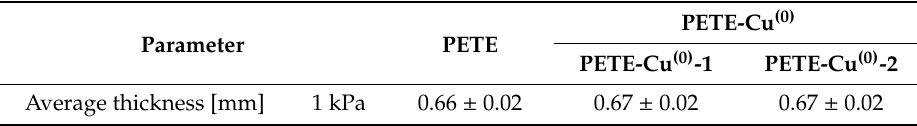
Table 6. Thickness of the unmodified PETE fabrics and PETE-Cu (0) composites, in accordance with the EN ISO 5084:1999 [117]. PETE-Cu (0) Parameter PETE PETE-Cu (0) -1 PETE-Cu (0) -2 Average thickness [mm] 1 kPa 0.66 ± 0.02 0.67 ± 0.02 0.67 ± 0.02